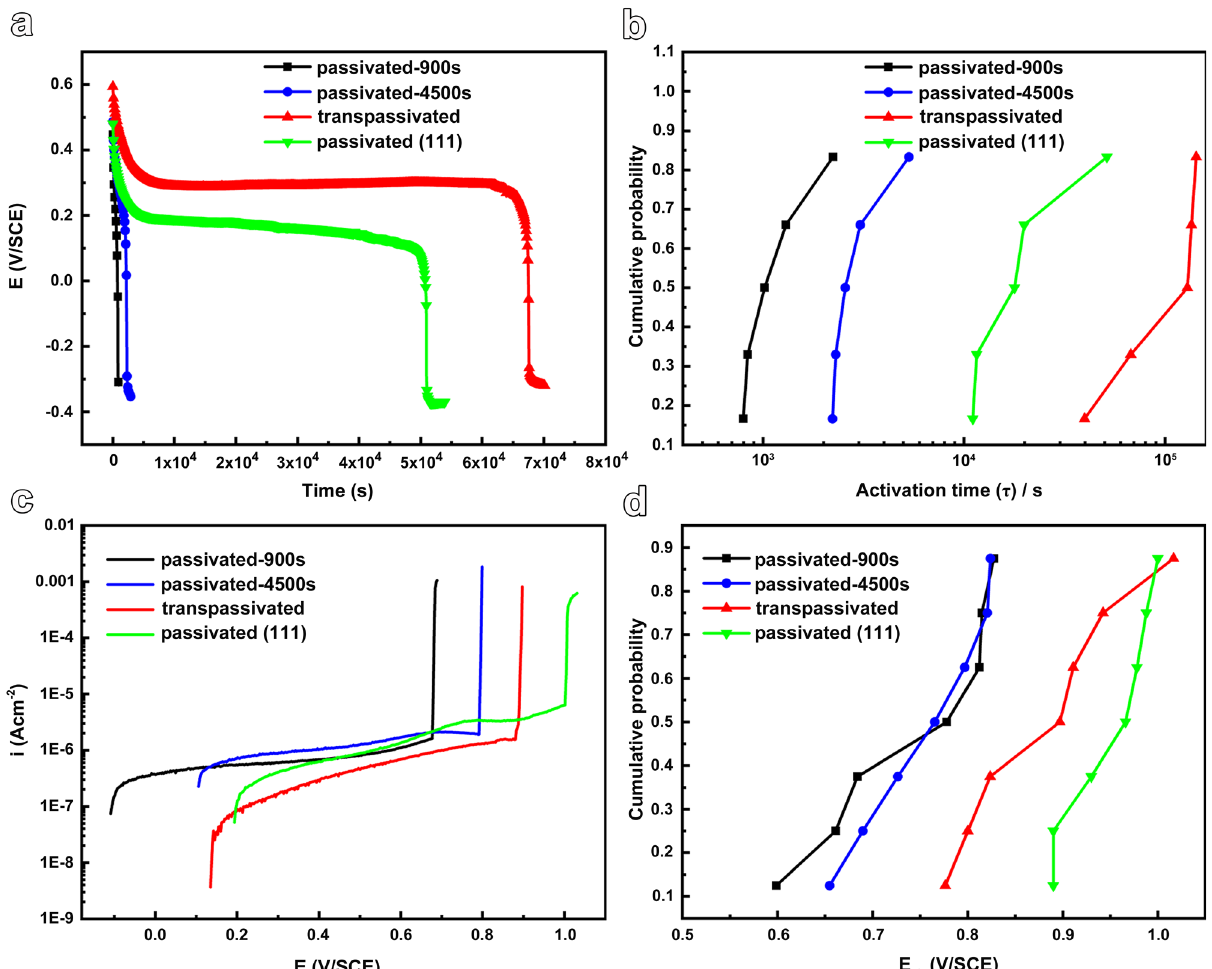
Fig. 7 Evaluating the enhancement of the resistance to reductive dissolution and to pitting corrosion induced by the lowest-energy {111} interface. a Typical potential decay curves of the four types of samples in 5.6 mol L − 1 H 2 SO 4 electrolyte at room temperature show that transpassivation treatment on the non-{111} surface, as well as passivation on the {111}surface, greatly extends the activation time. b The cumulative probability analysis of activation time ( τ ) shows the greatly improved resistance to reductive dissolution of the fi lms on the FeCr15Ni15 single-crystal alloy, induced by transpassivation treatment on the non-{111} surface, as well as passivation on the {111} surface. The τ values were obtained from the potential decay tests in 5.6 mol L − 1 H 2 SO 4 electrolyte at room temperature. c Typical potentiodynamic polarization curves of the four types of samples in 3.5% NaCl electrolyte at 50 °C. d The cumulative probability analysis of pitting potential (E pit ) shows the enhanced resistance to pitting corrosion induced by transpassivation treatment on the non-{111} surface, as well as passivation on the {111} surface. The E pit values were obtained from the potentiodynamic polarization tests in 3.5% NaCl electrolyte at 50